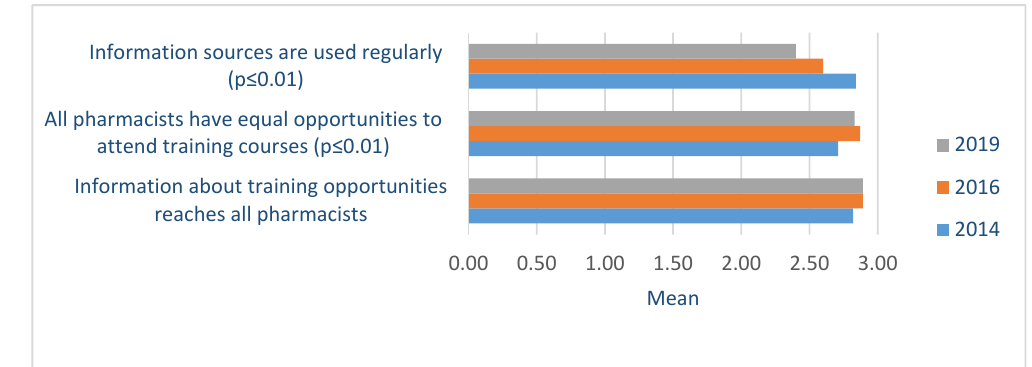
Figure 5. Following the principles of lifelong learning by community pharmacists based on the evaluation of the Community Pharmacy Services Quality Guidelines (four-point scale) in 2014-19.